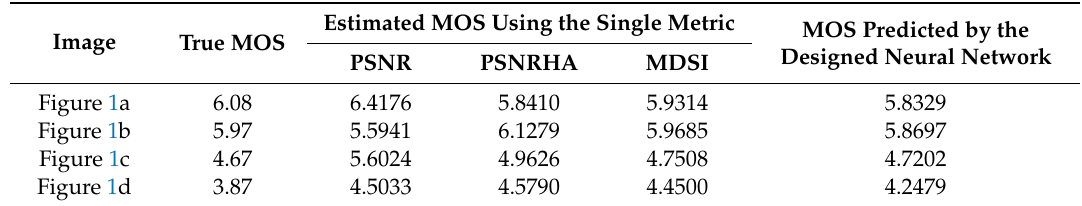
Table 8. True and Predicted MOS Values.